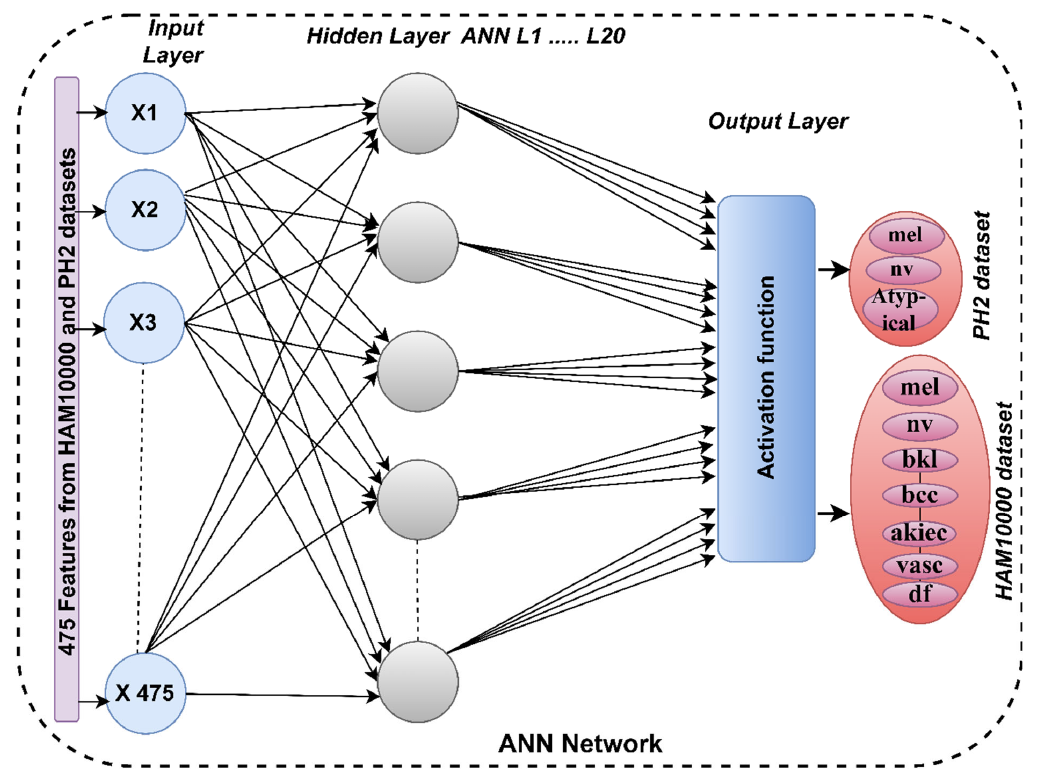
Figure 6. The basic structure of the ANN for the classification of dermoscopic images of the two datasets, HAM10000 and PH2.